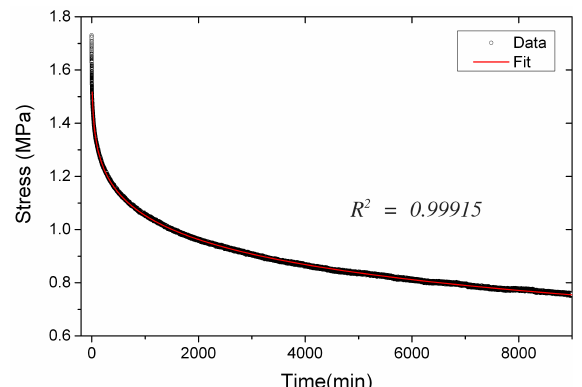
Figure 8. Experimentally-determined stress relaxation curve (made at − 5 ◦ C) and its fit with a stretched exponential relaxation function.